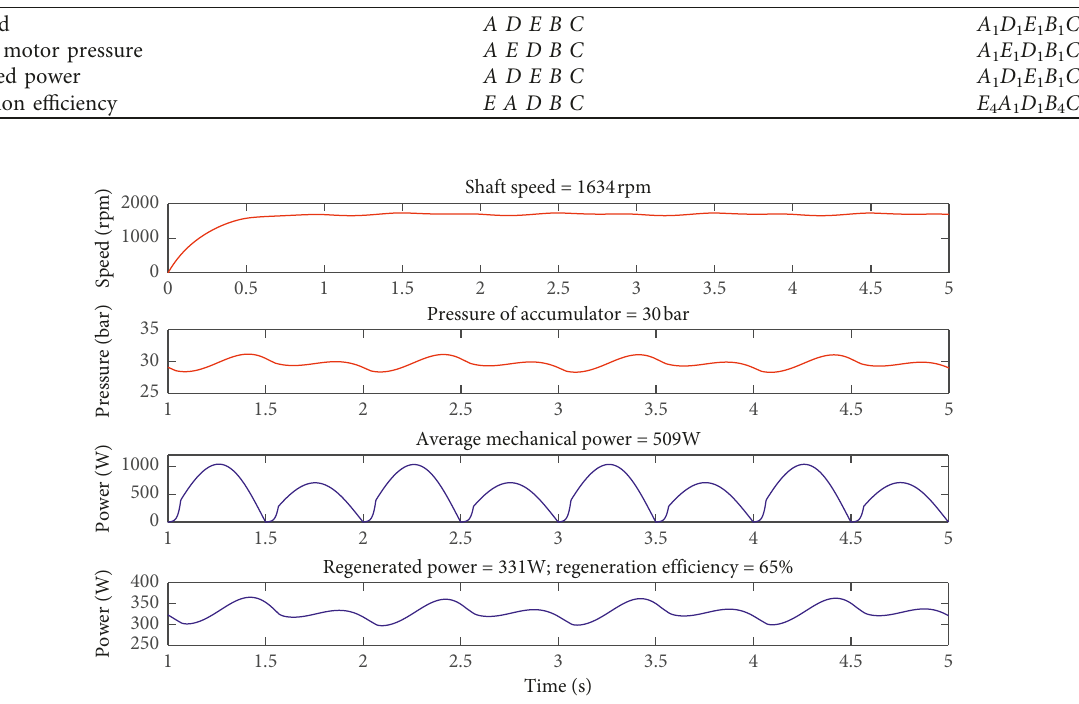
placement of motor: 5.77 cc, and the electrical load of